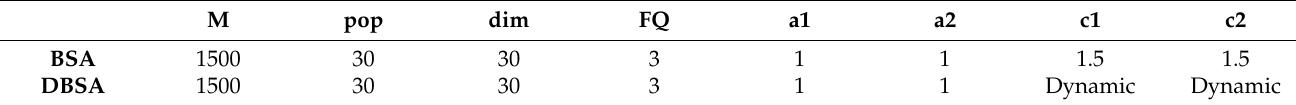
Table 2. Parameters used to solve the complex function of CEC2017.